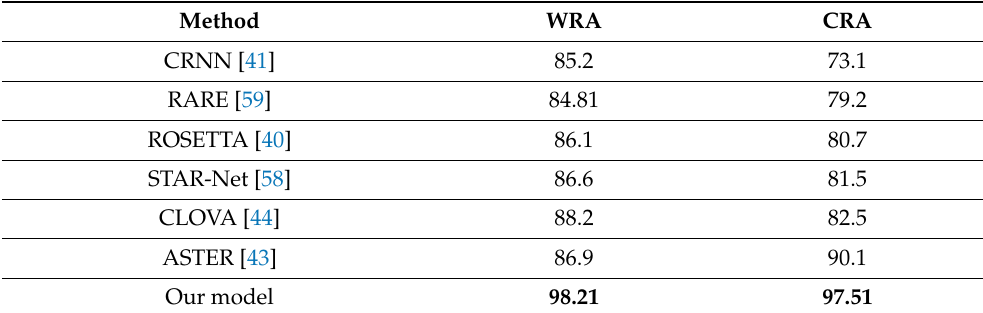
Table 3. These results compare the performance of our model (for text recognition) with that of relevant selected state-of-the-art models under the same conditions.